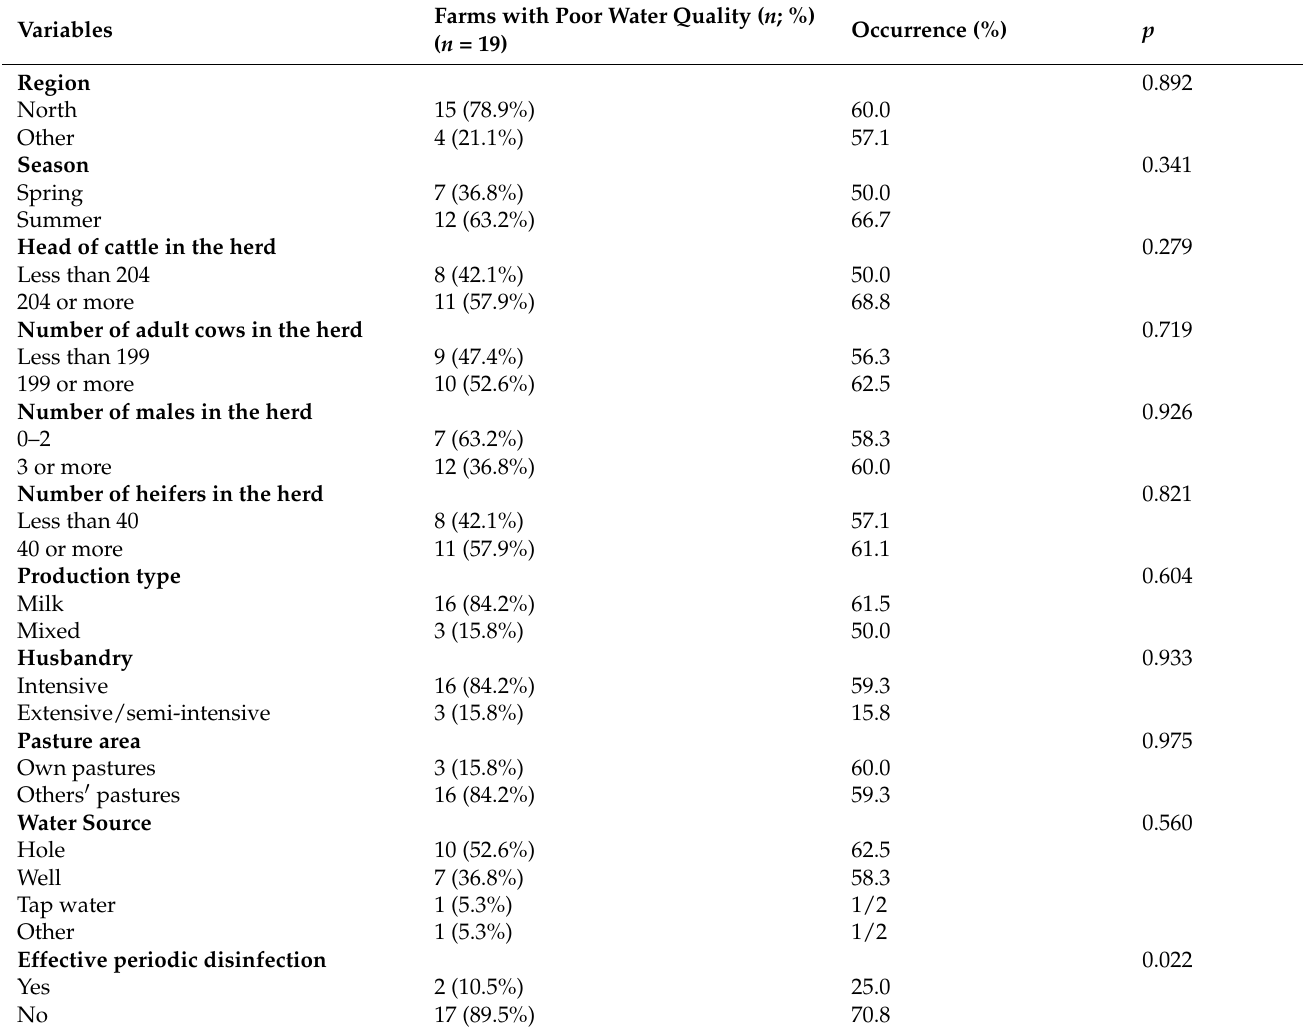
Table 1. Proportion of cattle farms in Portugal with poor water quality according to characteristics of the